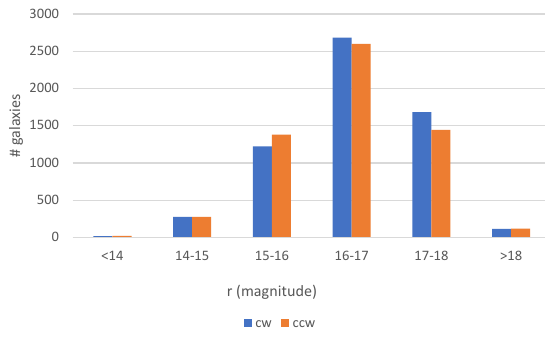
Figure 4. The distribution of Pan-STARRS clockwise and counter- clockwise galaxies in different r exponential